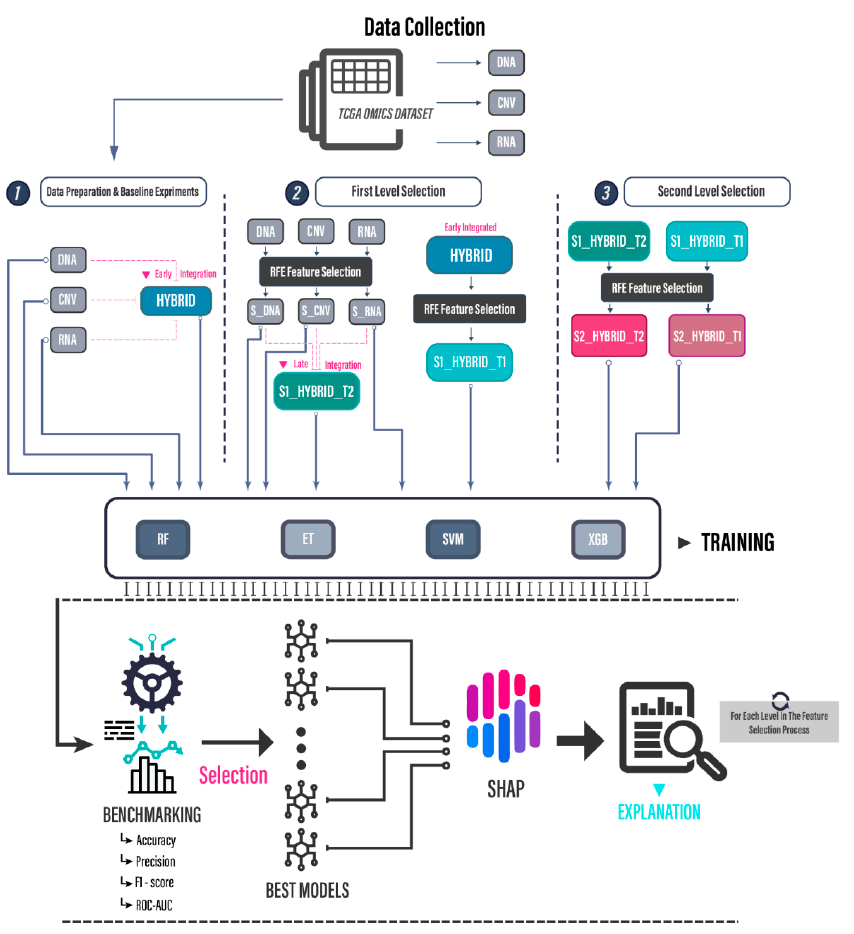
Figure 1. Proposed Framework: Two-Stage Feature Selection and Integration, Datasets and Mod- els.